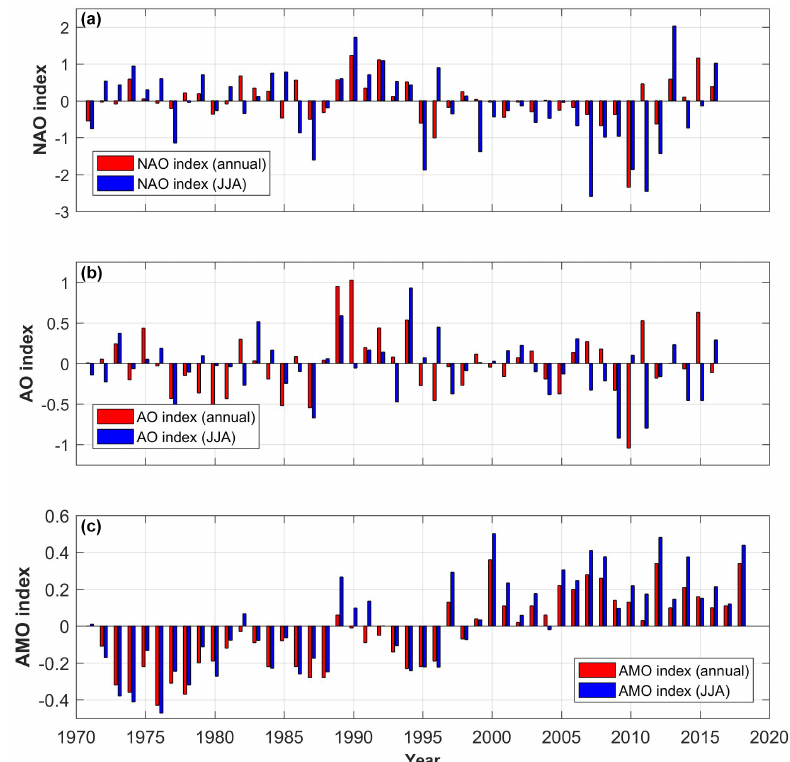
Figure 8. Time series of (a) North Atlantic Oscillation (NAO); (b) Arctic Oscillation (AO); and (c) Atlantic Multidecadal Oscillation (AMO) for 1970 to 2016. In each case, mean annual and mean summer values are